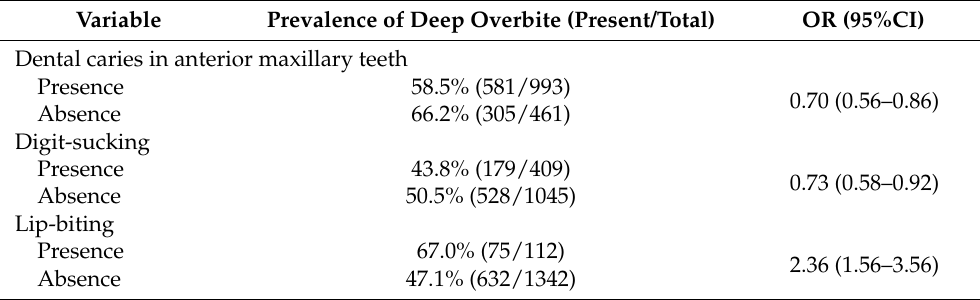
Table 6. Binary logistic regression analysis of relative factors and deep